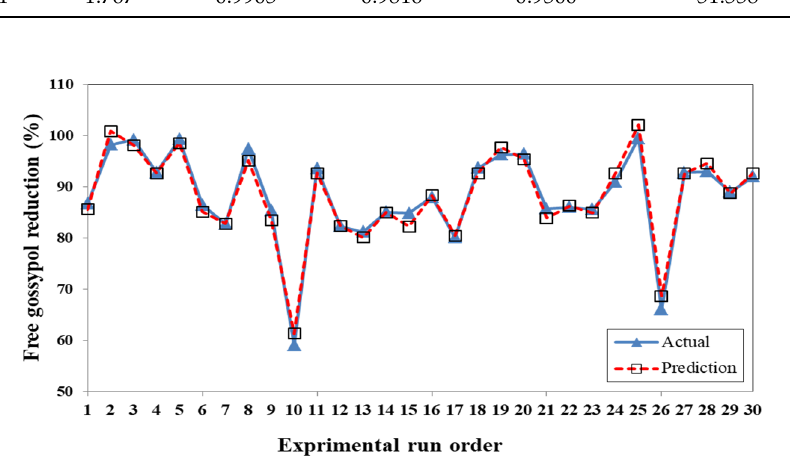
Figure 3. Comparison between measured and predicted values for FGR.